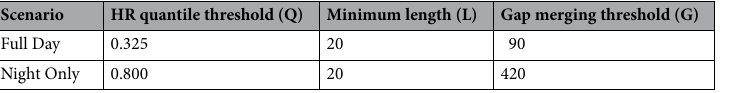
Table 3. Optimal hyper parameters extracted from a grid search on the BBVS dataset for both full-day and night-only data. These parameters are used accordingly on the other three datasets studied in this work.